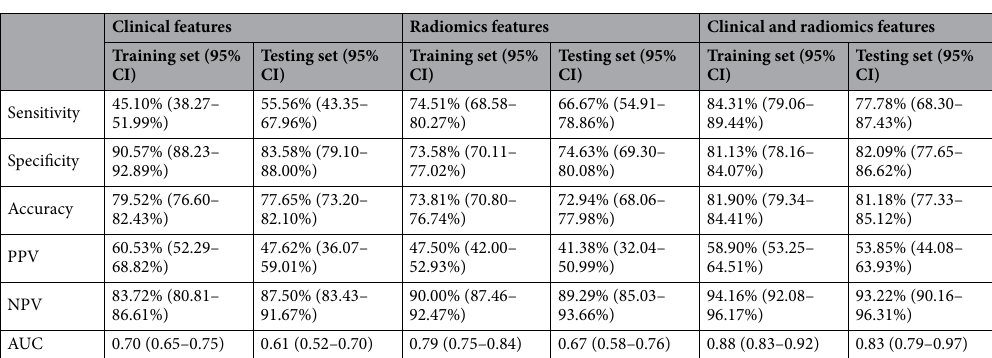
Table 2. Model performance for predicting neonatal respiratory morbidity depending on different features. Clinical features include pregnancy complications and gestational age. Radiomics features were based on free- hand delineation of region of interests by Radiologist A. CI confidence interval, PPV positive predictive value, NPV negative predictive value, AUC area under the receiver-operating-characteristics